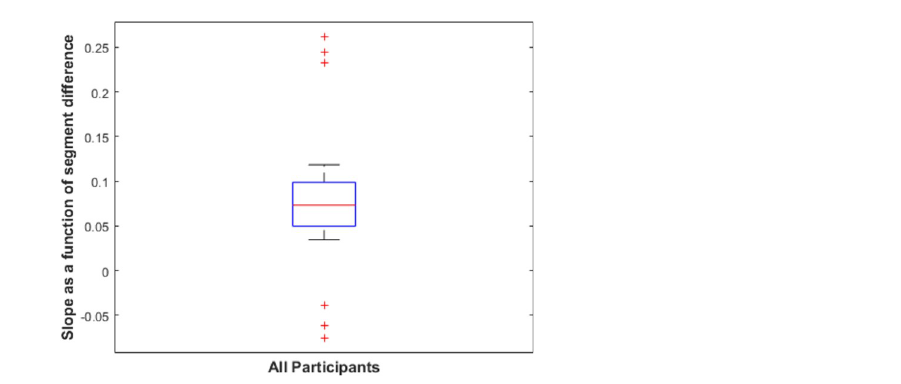
Fig 15. Boxplot of participants’ performance slopes as a function of constant curvature segment difference. The box shows the interquartile range of slopes for individual participants. The red line shows the sample median. The red line shows the sample median. The whiskers extend to the most extreme datapoint within 1.5 times the length of the interquartile range from the top or bottom edge of the box (covering 99.3% of the data if they are normally distributed). Outliers are data points beyond the whisker and are plotted as red +’s.